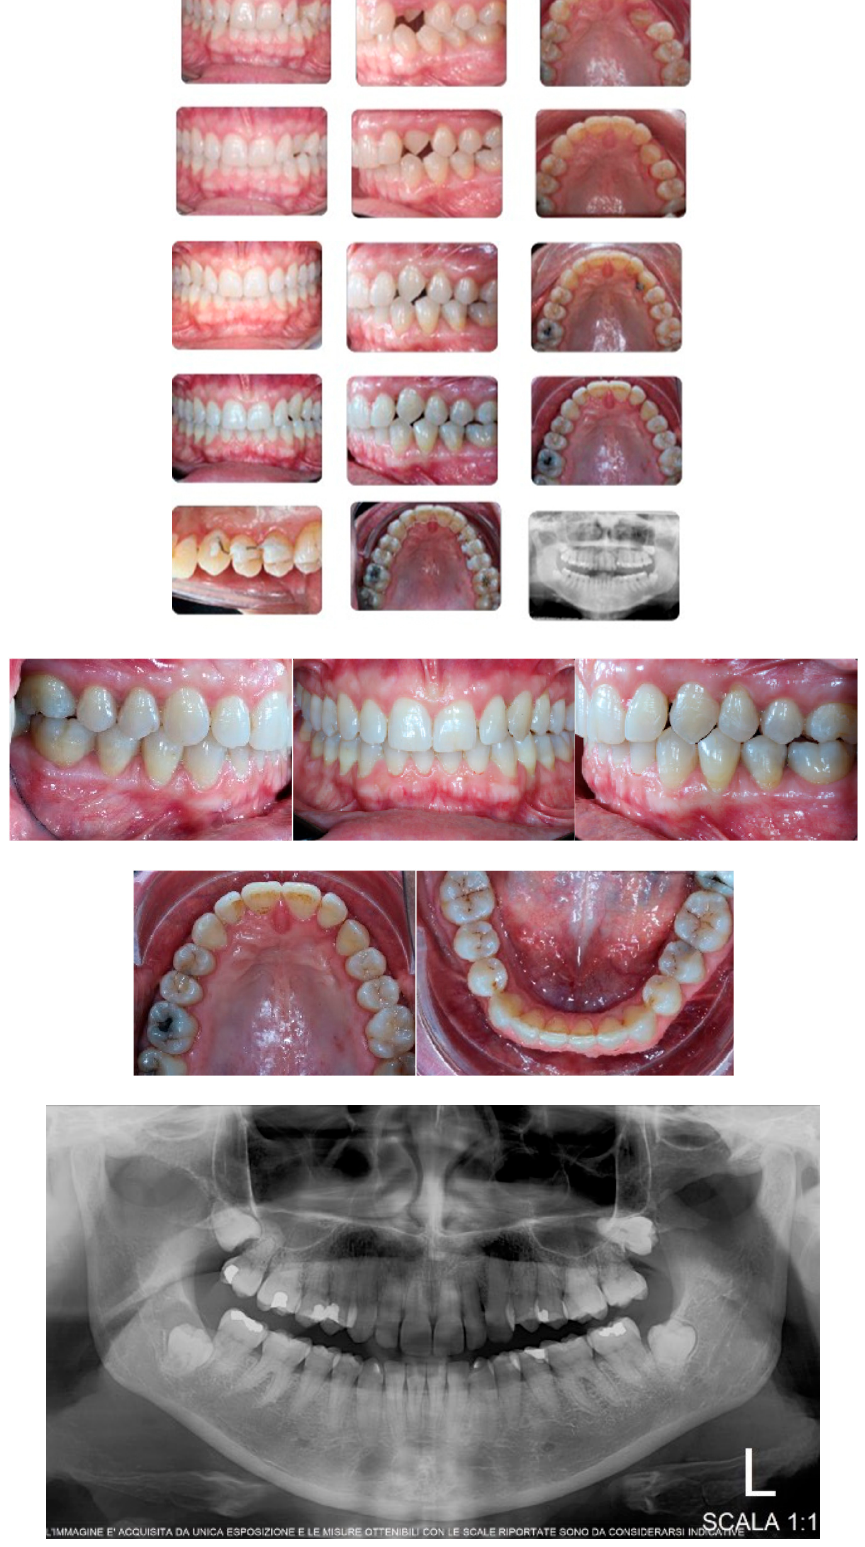
Figure 14. Presentation of all treatment phases as well as the final teeth position on the dental panoramic radiograph. For the same reason described above, only a panoramic X-ray was prescribed to the patient.